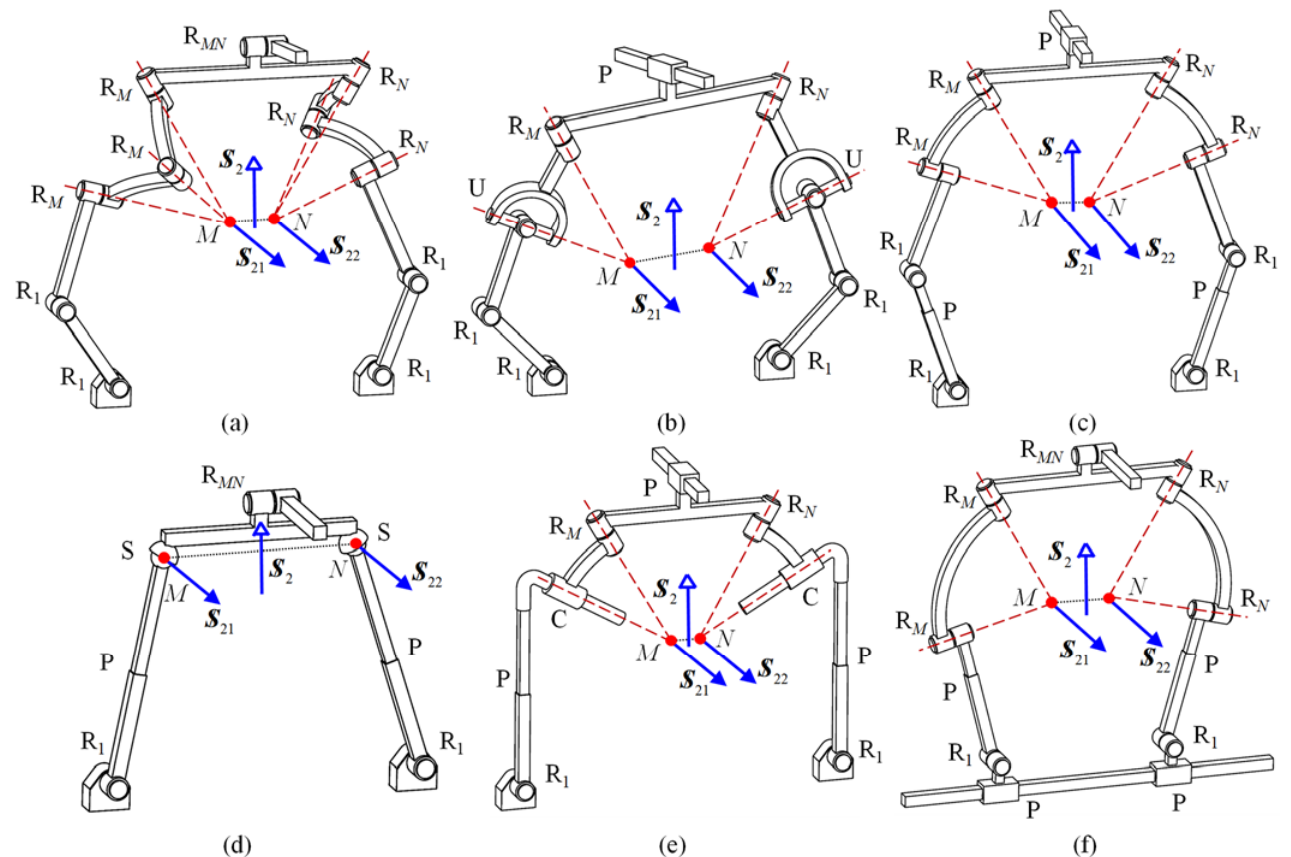
Figure 5. Typical C-hybrid limbs: ( a ) [R 1 R 1 R M R M R M -R 1 R 1 R N R N R N ]-R MN , ( b ) [R 1 R 1 UR M -R 1 R 1 UR N ]- Figure 5. Typical C ‐ hybrid limbs: ( a ) [R 1 R 1 R M R M R M ‐ R 1 R 1 R N R N R N ] ‐ R MN , ( b ) [R 1 R 1 UR M ‐ R 1 R 1 UR N ] ‐ P, ( c ) [R 1 PR 1 R M R M ‐ R 1 PR 1 R N R N ] ‐ P, ( d ) [R 1 PS ‐ R 1 PS] ‐ R MN , ( e ) [R 1 PCR M ‐ R 1 PCR N ] ‐ P, ( f ) [PR 1 PR M R M ‐ P, ( c ) [R 1 PR 1 R M R M -R 1 PR 1 R N R N ]-P, ( d ) [R 1 PS-R 1 PS]-R MN , ( e ) [R 1 PCR M -R 1 PCR N ]-P, ( f ) [PR 1 PR M R M - PR 1 PR N R N ] ‐ R MN . PR 1 PR N R N ]-R MN